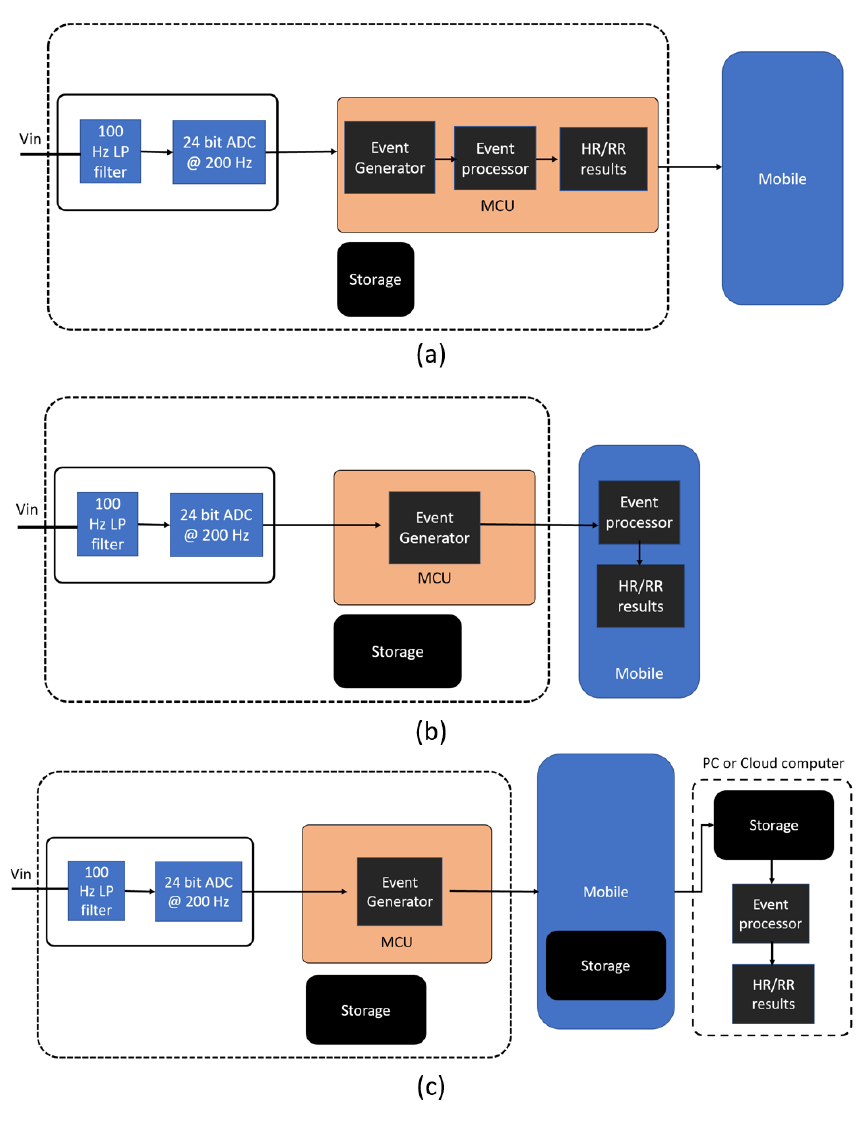
Figure 4. The abstract view of the event-based data processing flows in ( a ) event processing at MCU, ( b ) event processing at a mobile device, and ( c ) event processing at a PC or a cloud computer. A Biopac AMI100D amplifier input module was used to capture data from the instru- mentation circuit into a PC with a 10 kHz sample rate. The data are imported into